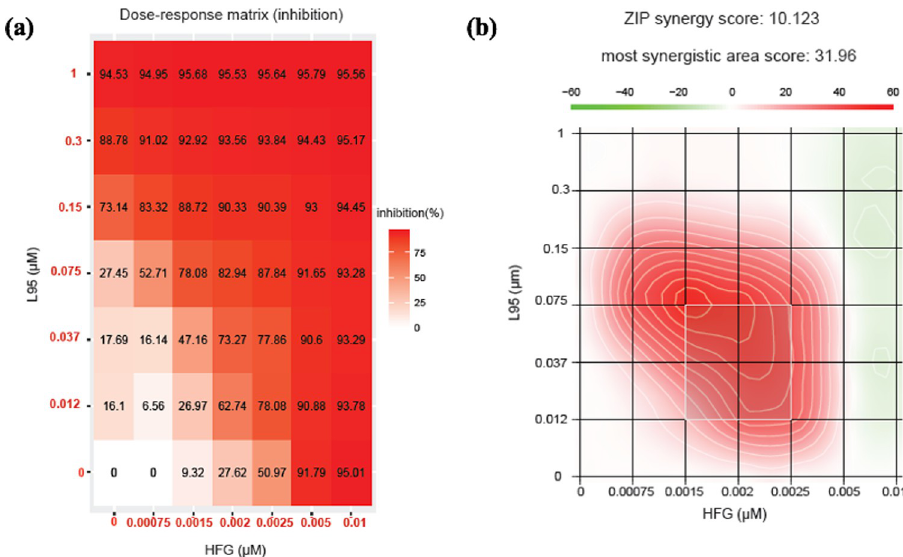
Fig 5. Combinational inhibition profile of HFG and L95 against parasite cell-based system. (a) Dose-response matrix of L95 and HFG on RH NLuc T . gondii parasites after 48 h of growth in presence of the indicated concentrations of each compound. The concentration gradient for HFG used was 0 to 0.01 μ M and for L59 was 0 to 1 μ M. Percentages of growth inhibition were determined based on measured luminescence. (b) Synergy landscape showing synergistic and antagonistic dose regions in red and green respectively, as determined using the Synergy Finder application with the ZIP reference model. The synergy score for a drug combination is averaged (10.123) over all the dose combination measurements (ZIP synergy score). The most synergistic area (score of 31.96) is delimited by a white square.